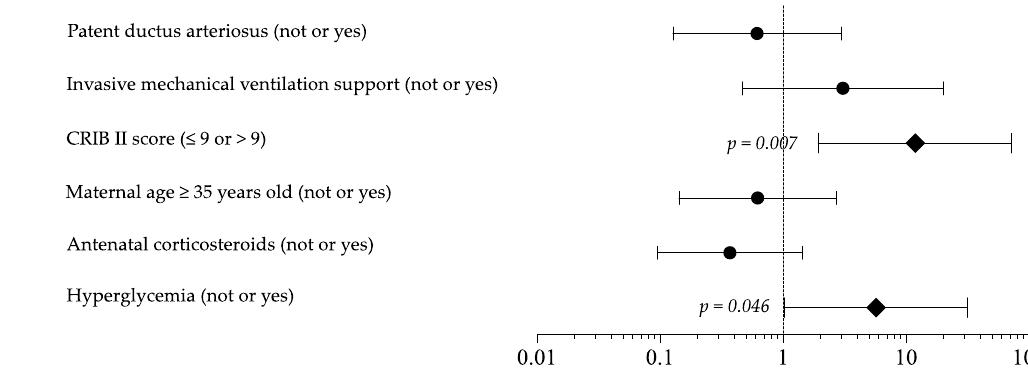
Figure 2. Logistic regression analysis to evaluate the influence of covariates on mortality rate. Figure legend: CRIB (clinical risk index for babies).